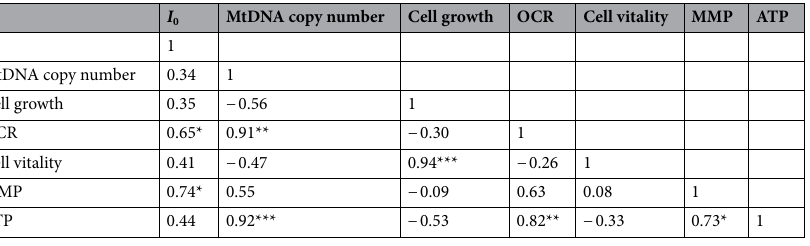
Table 1. Correlation analyses. Pearson correlation was analyzed by SPSS25.0 software. * p < 0.05. ** p < 0.01. *** p <